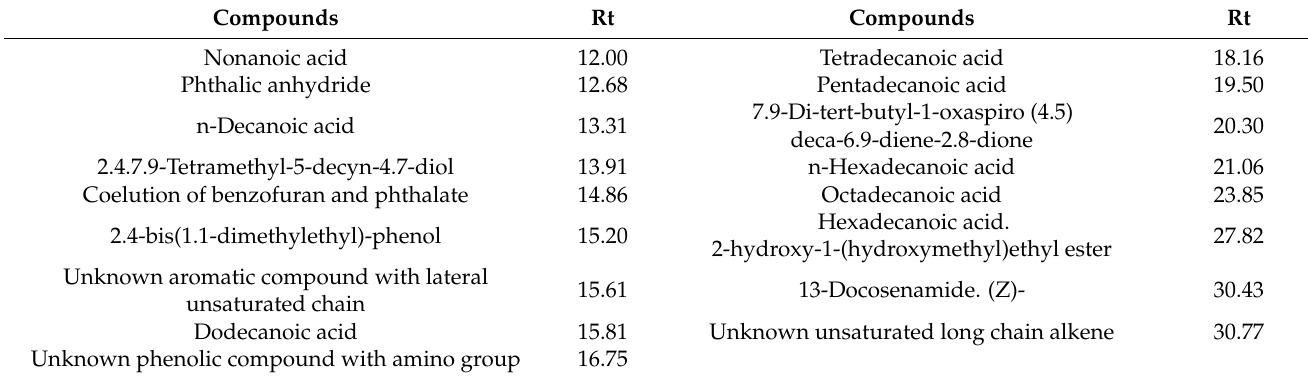
Table 2. Main compounds identified in crude oil by GC-MS. Rt indicates the retention time expressed in